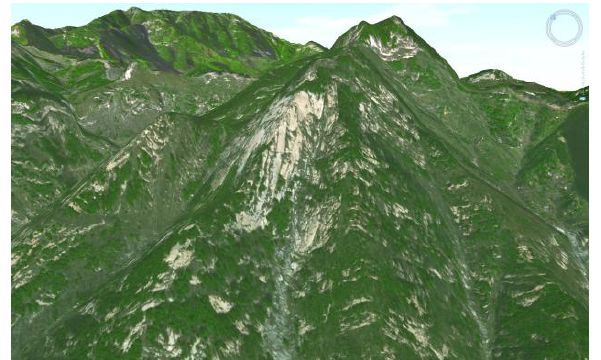
Figure 7. Steep cliffs and joints of Taishan